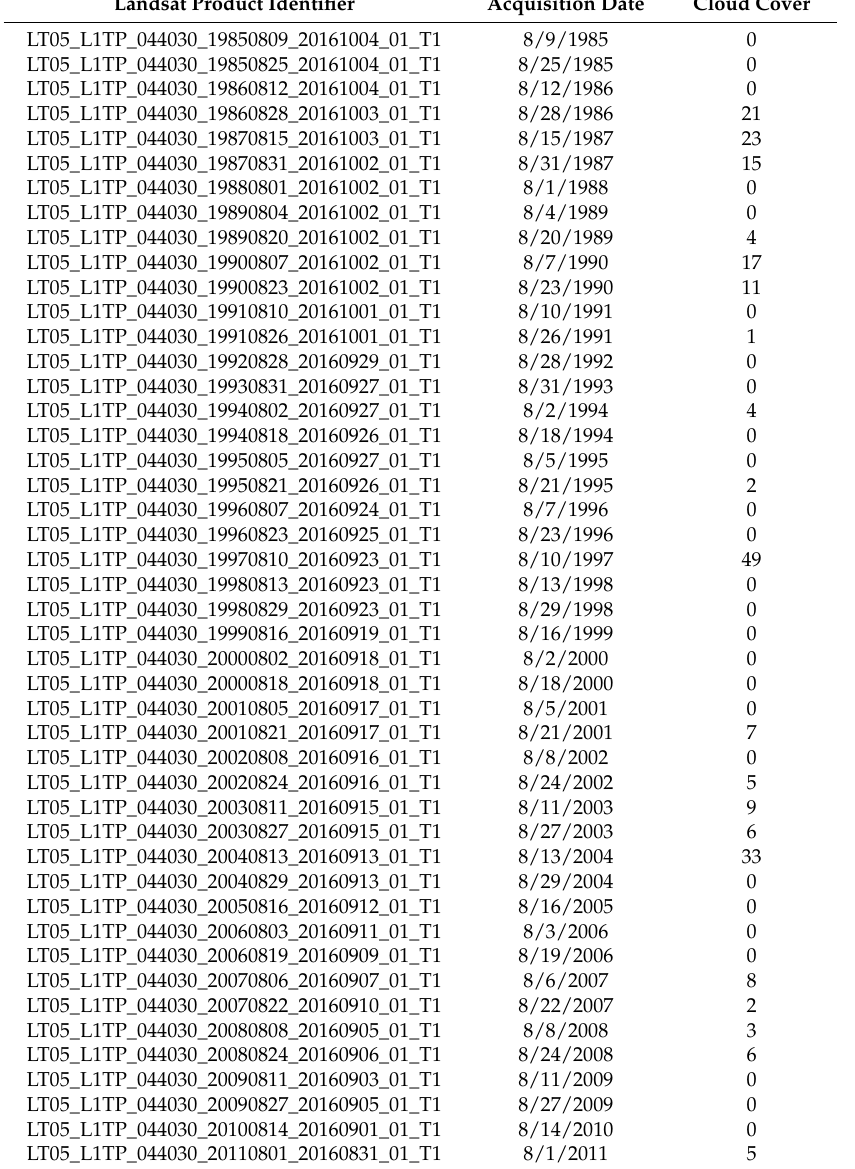
Table A2. Landsat scenes for which Normalized Differenced Moisture Index (NDMI) was analyzed in this